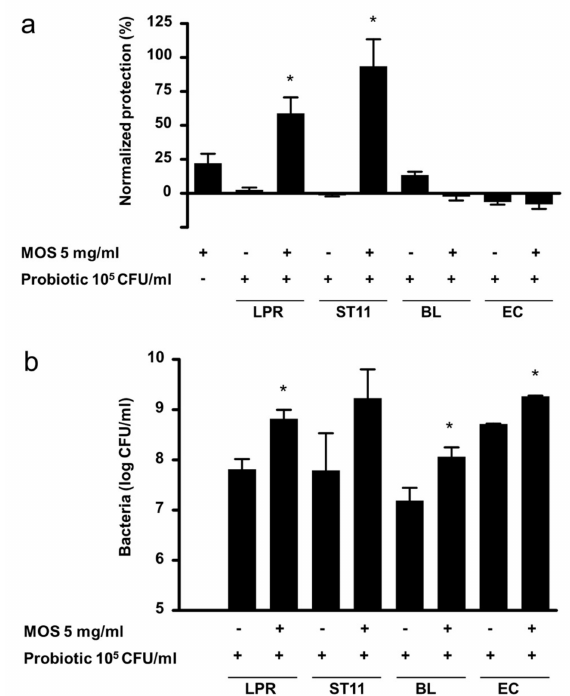
Figure 4. ( a ) Protection of T84 epithelial cells from barrier integrity damage by C. di ffi cile toxin A. T84 cells were preincubated for 2 h with MOS, in the absence or presence of 10 5 / mL L. rhamnosus (LPR), L. paracasei (ST11), B. longum BL NCC3001 (BL) or E. coli Nissle (EC) prior to the addition of C.di ffi cile toxin A. T84 transepithelial resistance was measured before sample addition and after 20